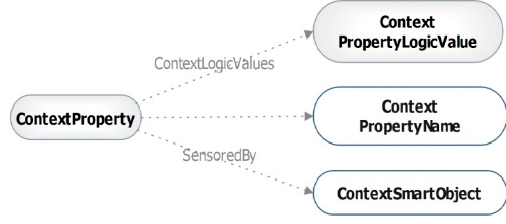
Figure 12. Context property sub ‐ ontology.